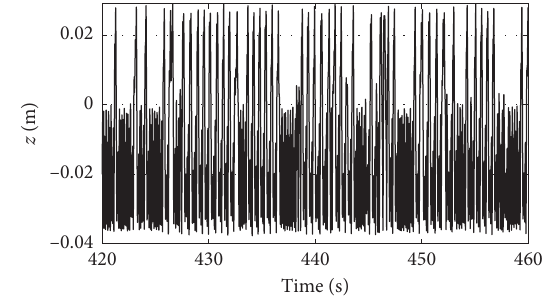
Figure 13: Time response under harmonic excitation, b